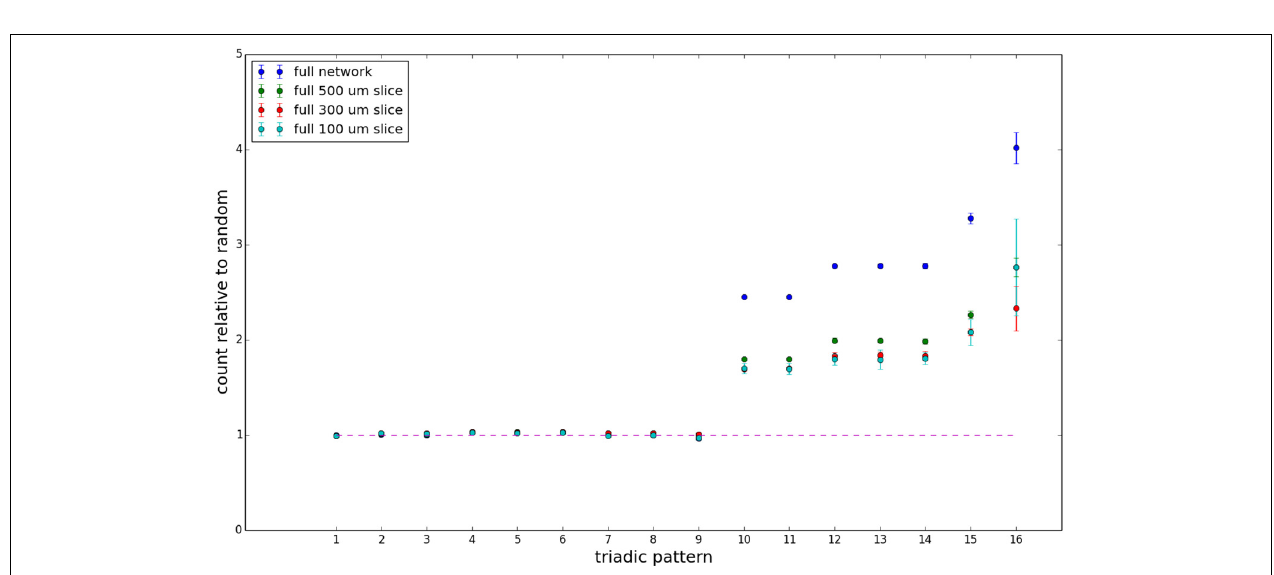
FIGURE 10 | Bidirectionally corrected triadic motif counts for complete sections (full sampling). Error bars indicate standard error of the mean. Average over five